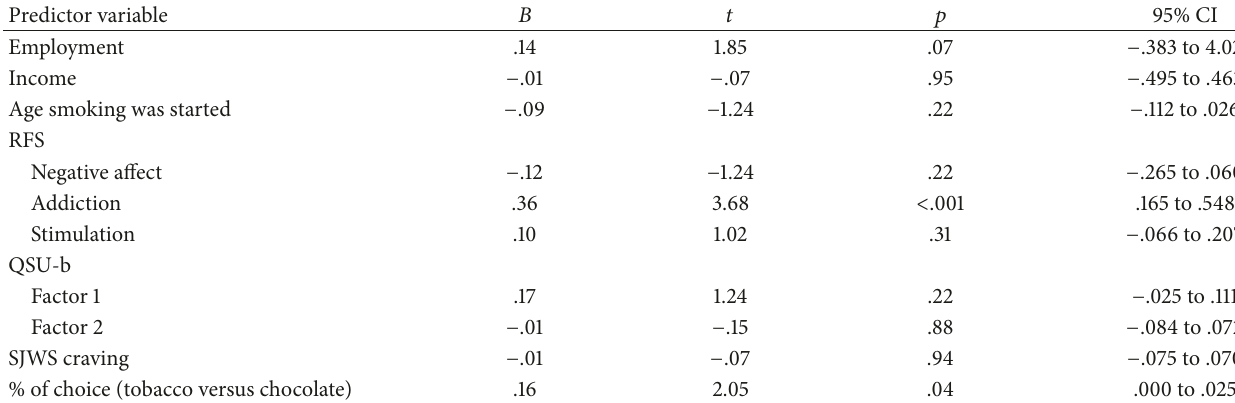
Table 4: Multiple regression analysis predicting scores on Fagerstr¨om Test for Nicotine